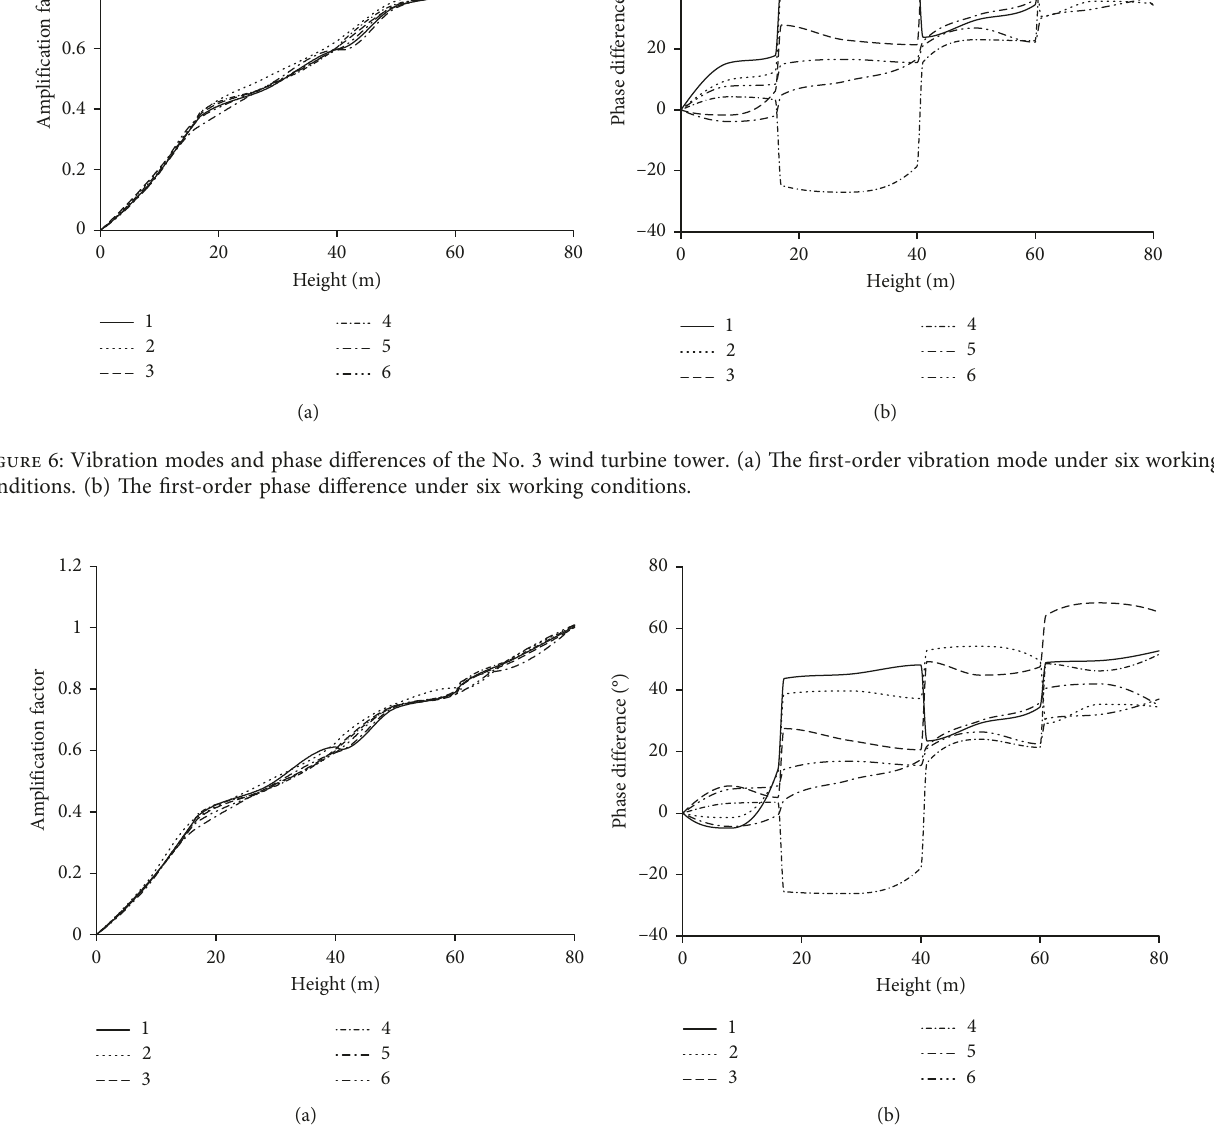
Figure 7: Vibration modes and phase differences of the No. 4 wind turbine tower. (a) The first-order vibration mode under six working conditions. (b) The first-order phase difference under six working